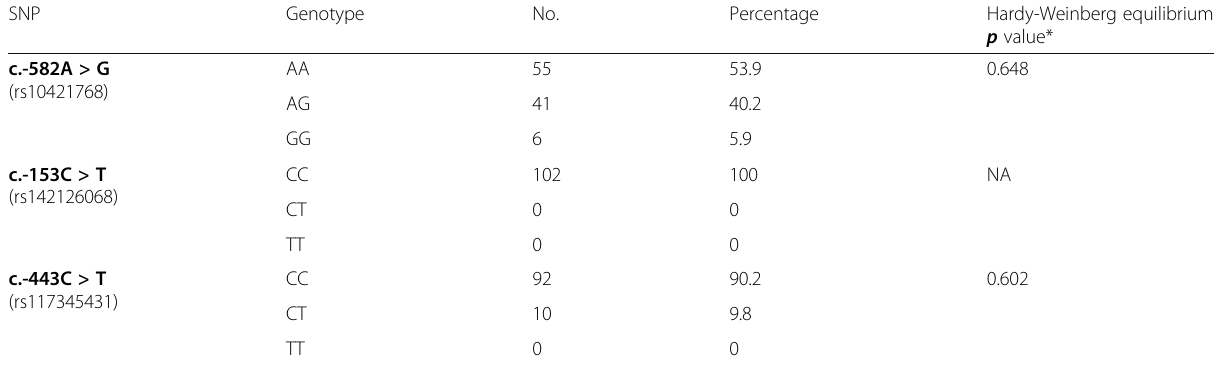
Table 3 Genotyping result of c.-582A > G, c.-153C > T, and c.-443C > T